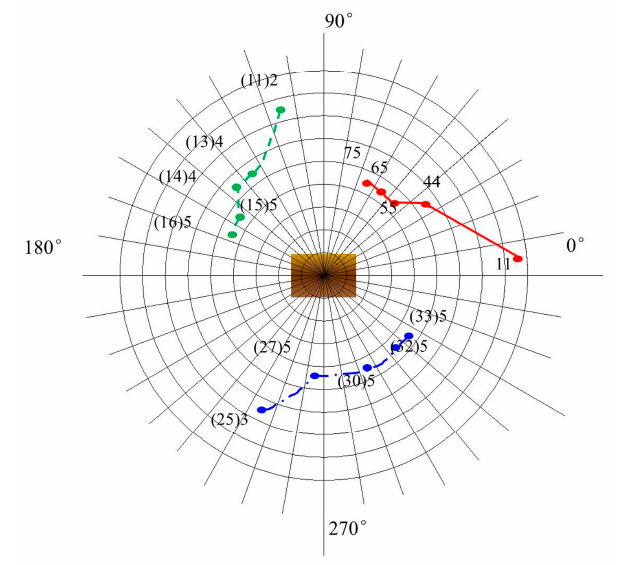
Figure 13. Four-view optimal observation paths.